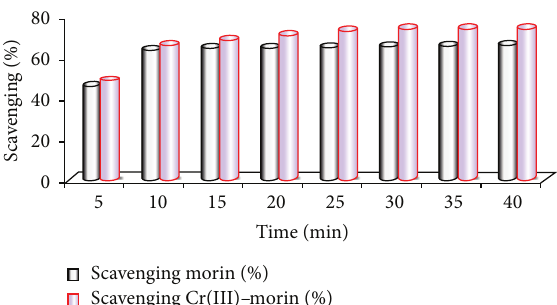
Figure 5: Relative antioxidative potential of morin and Cr(III)- morin complex.